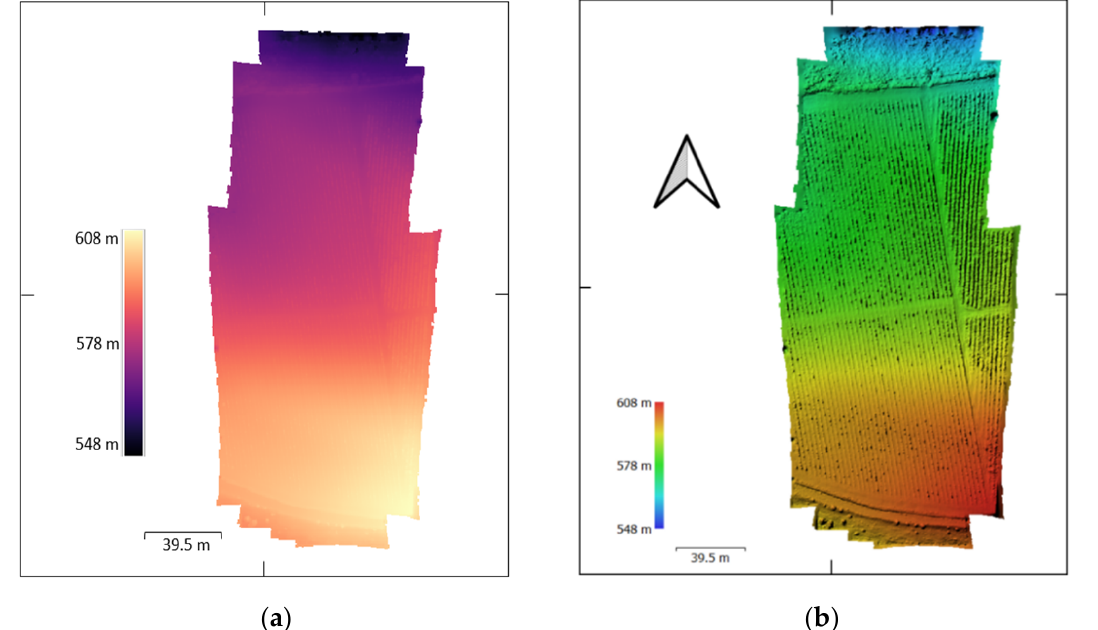
Figure 6. Representation of the elevation distribution of a vineyard obtained using UAV images; ( a ) Representation of a Digital Terrain Model; ( b ) Digital Surface Model.